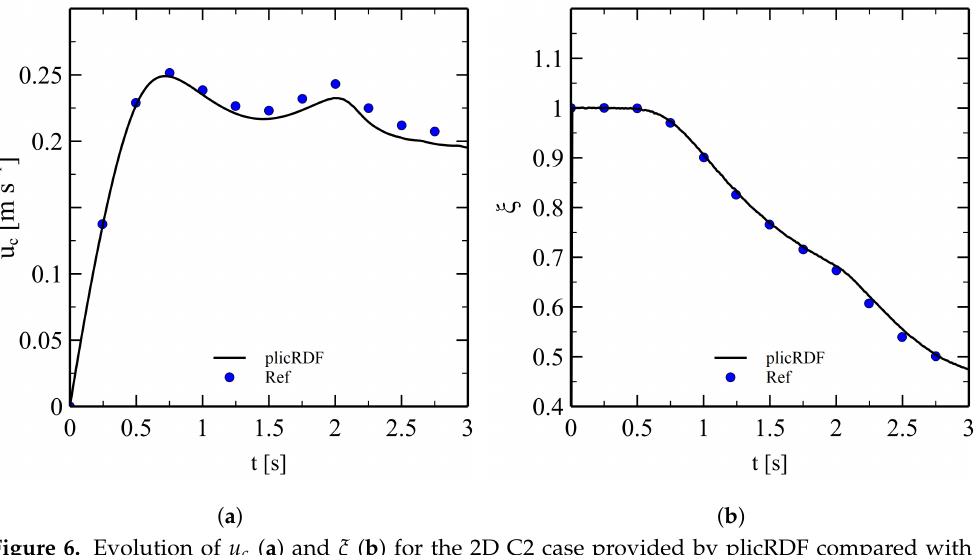
Figure 6. Evolution of u c ( a ) and ξ ( b ) for the 2D C2 case provided by plicRDF compared with FreeLIFE code in Ref.